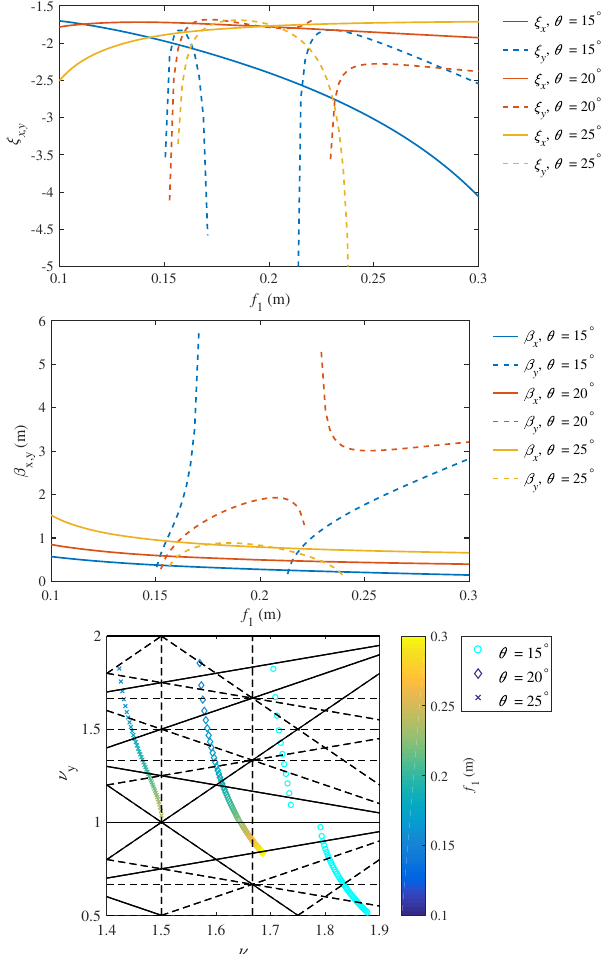
FIG. 4. Chromaticity, betatron functions at IP, and betatron tunes with different quadrupole focal lengths and edge